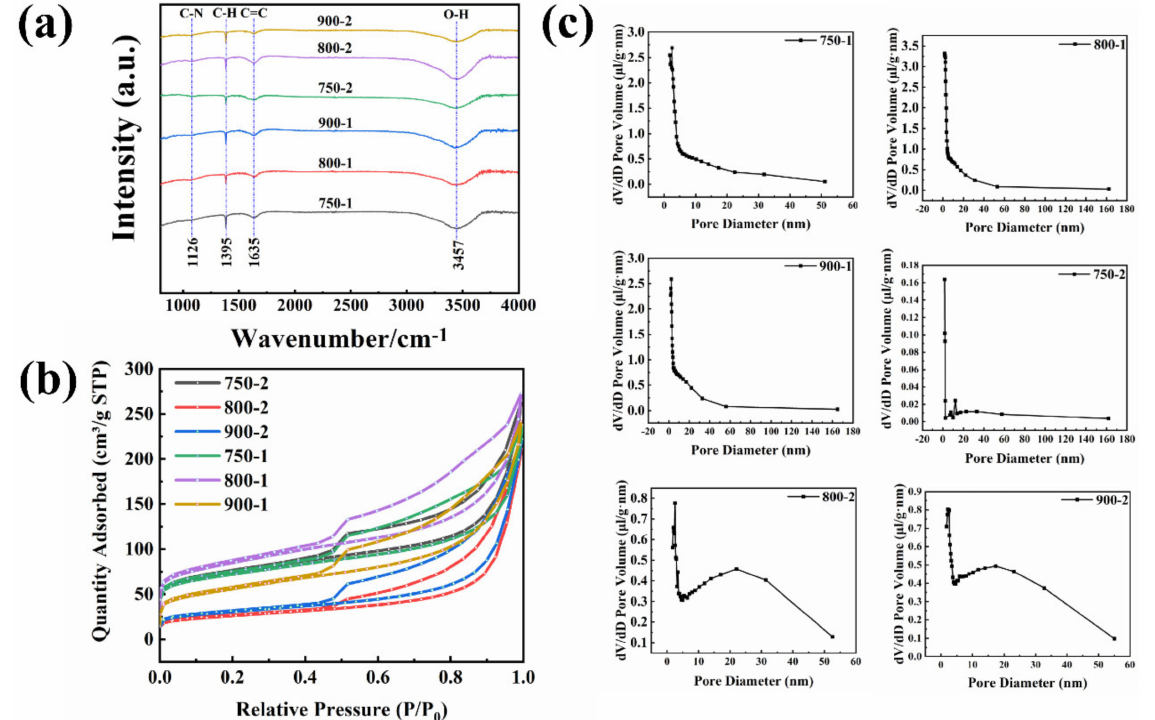
Figure 3. ( a ) FTIR of the graphitized peel; ( b ) N 2 adsorption–desorption isotherms for the graphitized peel; ( c ) Pore size distribution image of the graphitized